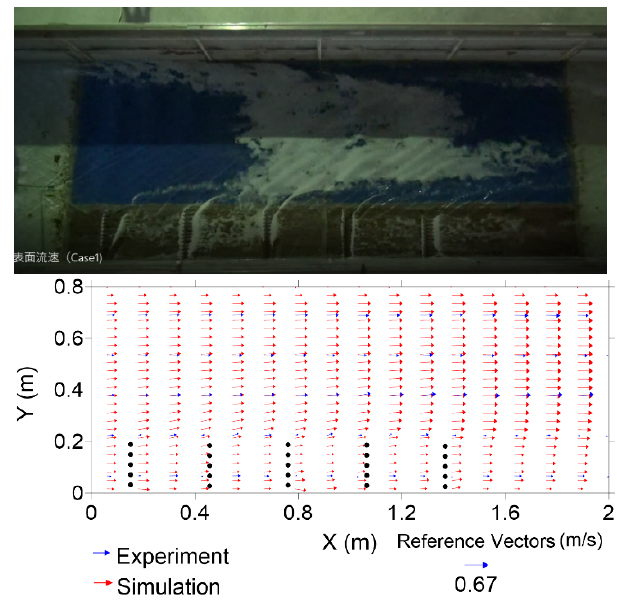
Figure 5. Comparison of experimental and simulated surface velocities for case 1.